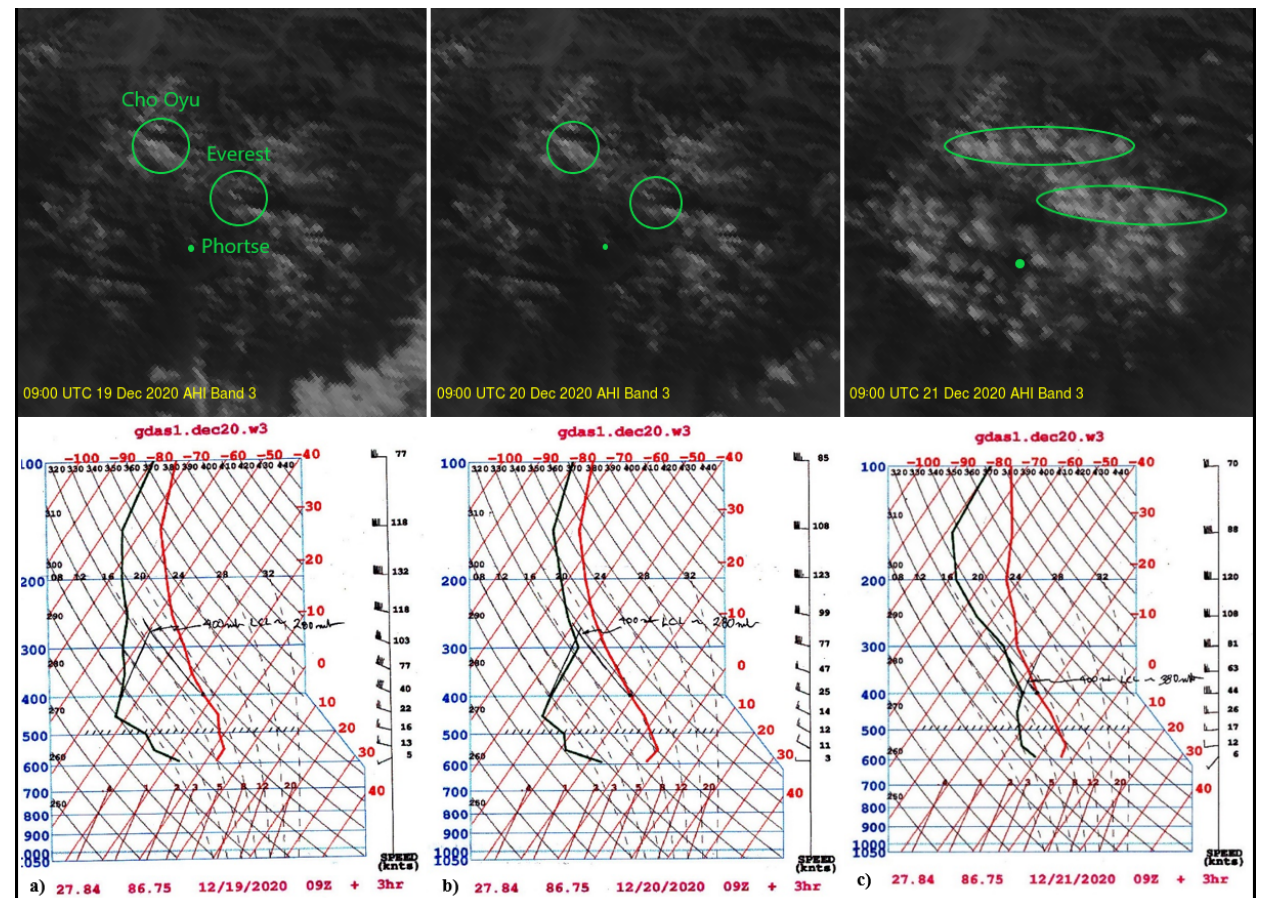
Figure 5. The images and profiles (a) , (b) , and (c) are for 19, 20, and 21 December 2020, at 09:00 UTC (15:00 LST). The major peaks are circled and the location of Phortse is labeled. The LCL values are determined graphically on the corresponding atmospheric profiles from Phortse and are listed in Table 1. The graphical procedures are described in the text. The pressures at the base and summit of the Everest pyramid, respectively, are approximately 400 and 300mb.